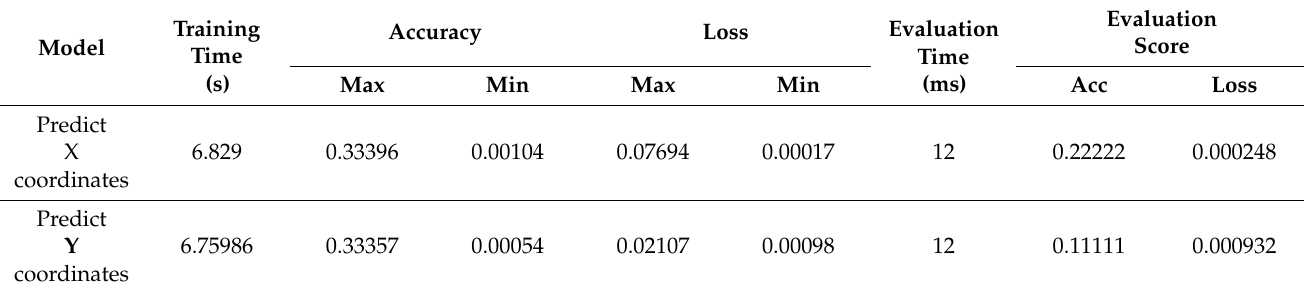
Figure 21. Lane line detection. We demonstrated the entire process of lane line detection in five rows: ( a ) the ground truth, ( b ) find four points, ( c ) edge detection, ( d ) projection transformation, ( e ) and ( f ) find curve equation, ( g ) draw lane area, ( h ) projection transformation again; ( i ) and ( j ) are the results of the final lane line detection. Table 11. The training results of car trajectory prediction